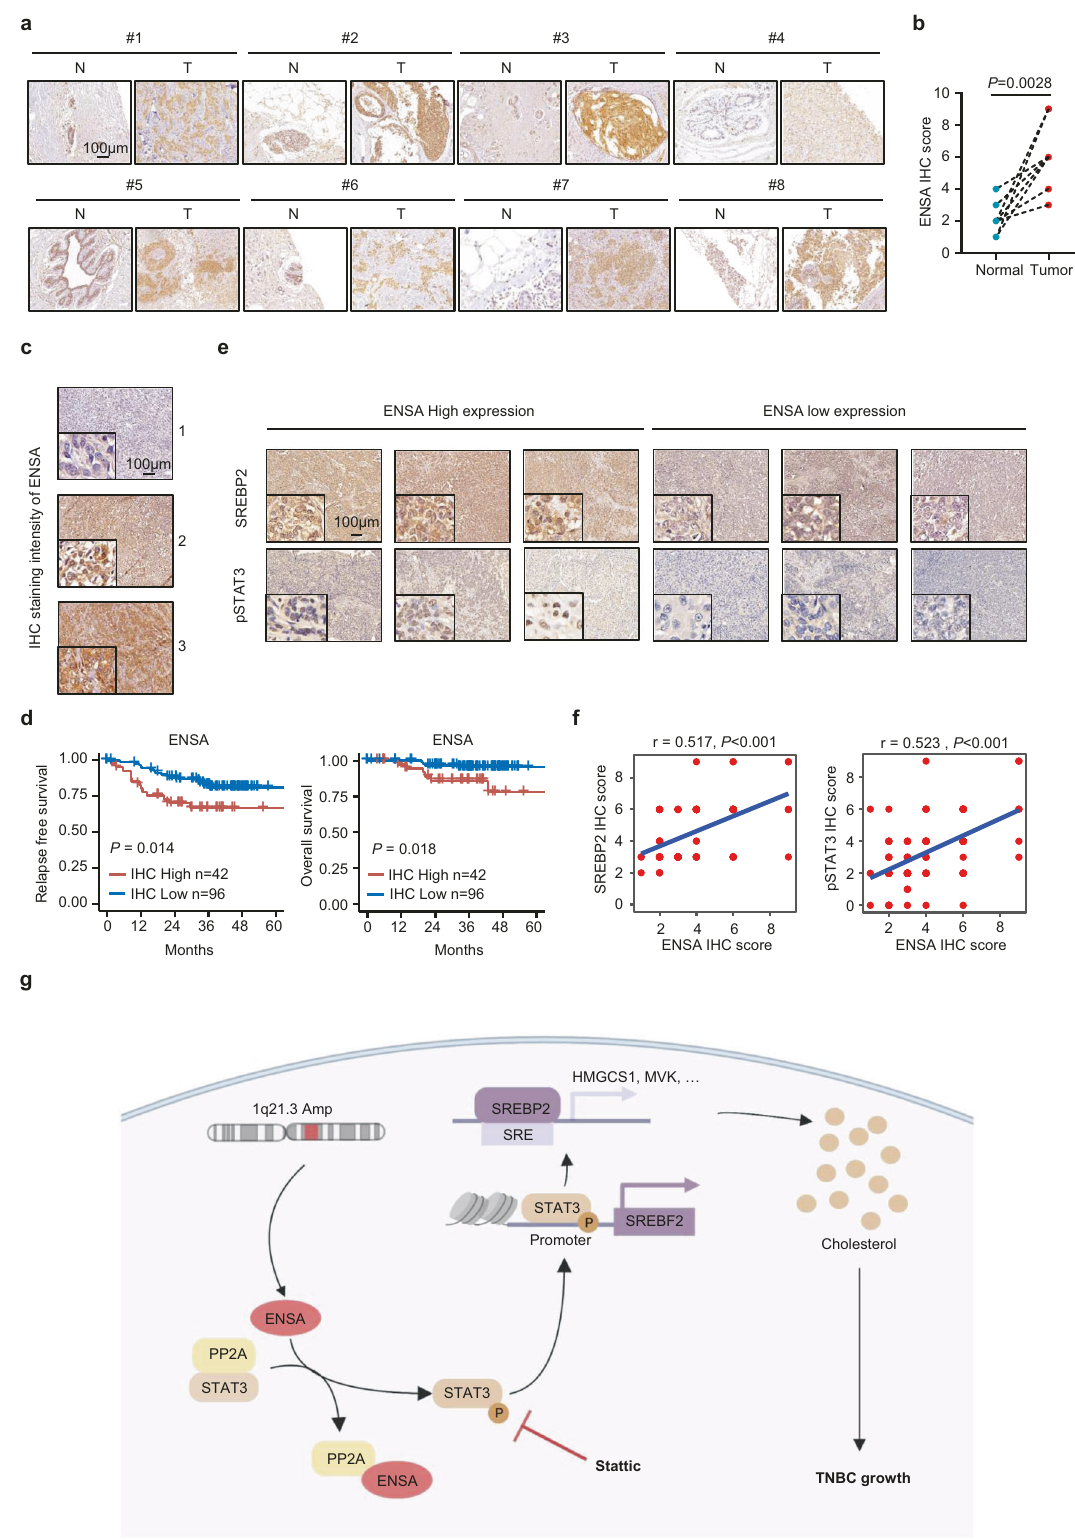
kit of the Illumina Xten system (Vazyme, Nanjing, China) was used to prepare the RNA-seq libraries according to the manufacturer ’ s instructions. Brie fl y, polyA + RNA samples (~100ng) were fragmented and reverse transcribed into double strand cDNA. Then these cDNA fragments went through end repair, the addition of adenine tails, and ligation of the adaptors processes. The puri fi ed products were subjected to 12 cycles of PCR ampli fi cation to create the fi nal cDNA libraries. These libraries were sequenced on 150 bp paired-end Illumina sequencing